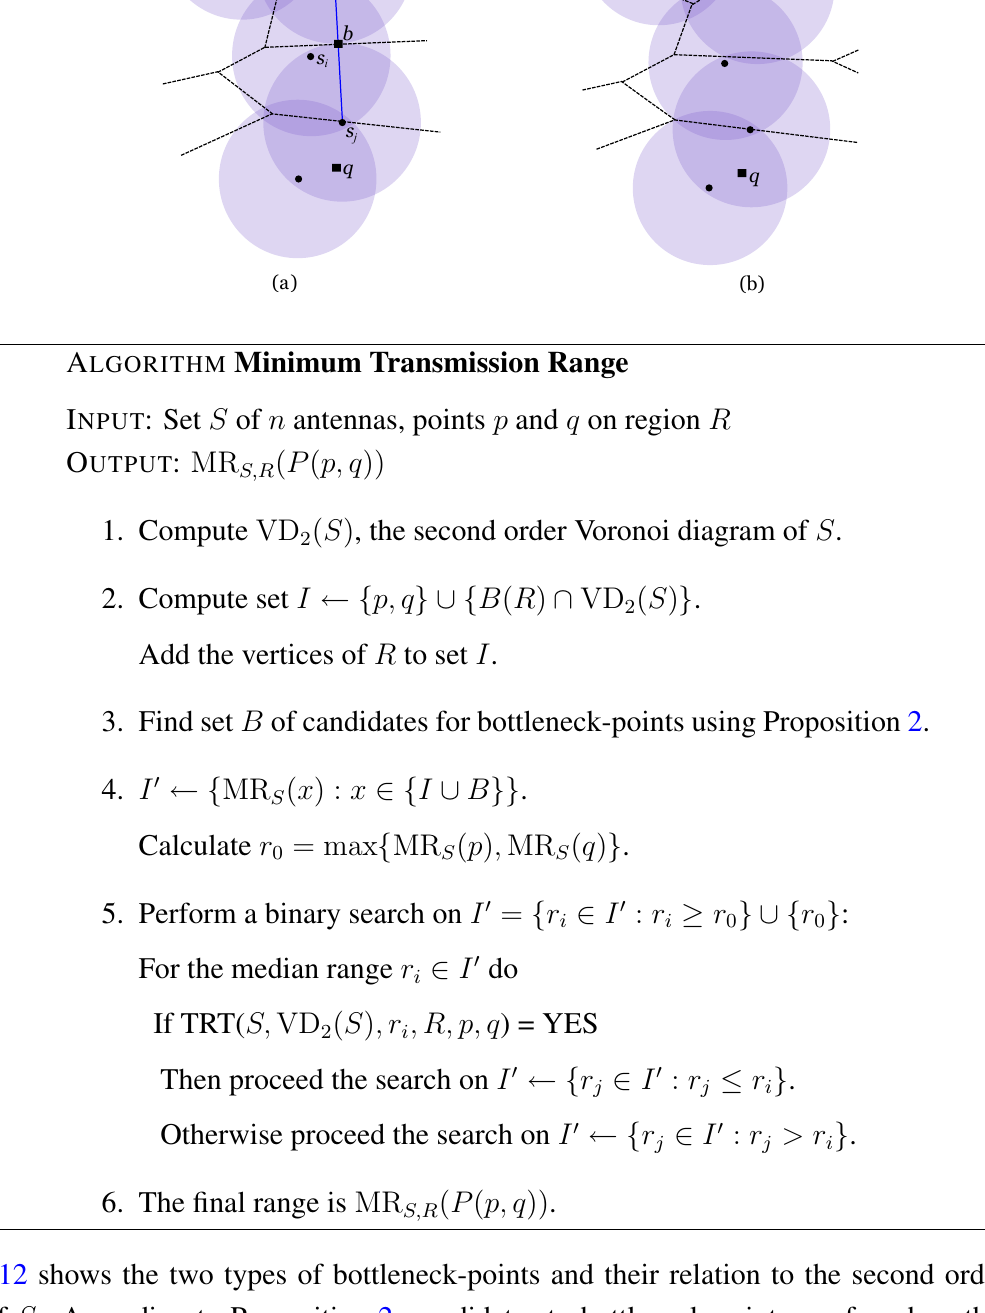
( p, q ) is a type I bottleneck-point. (b) Point b = b S